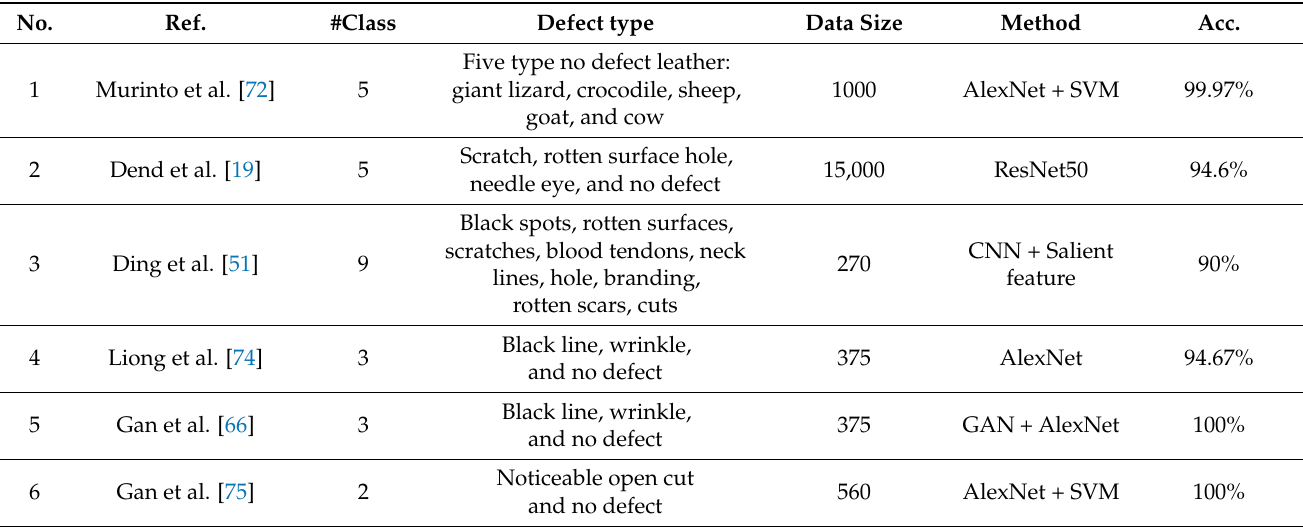
Table 9. Deep learning for leather defect